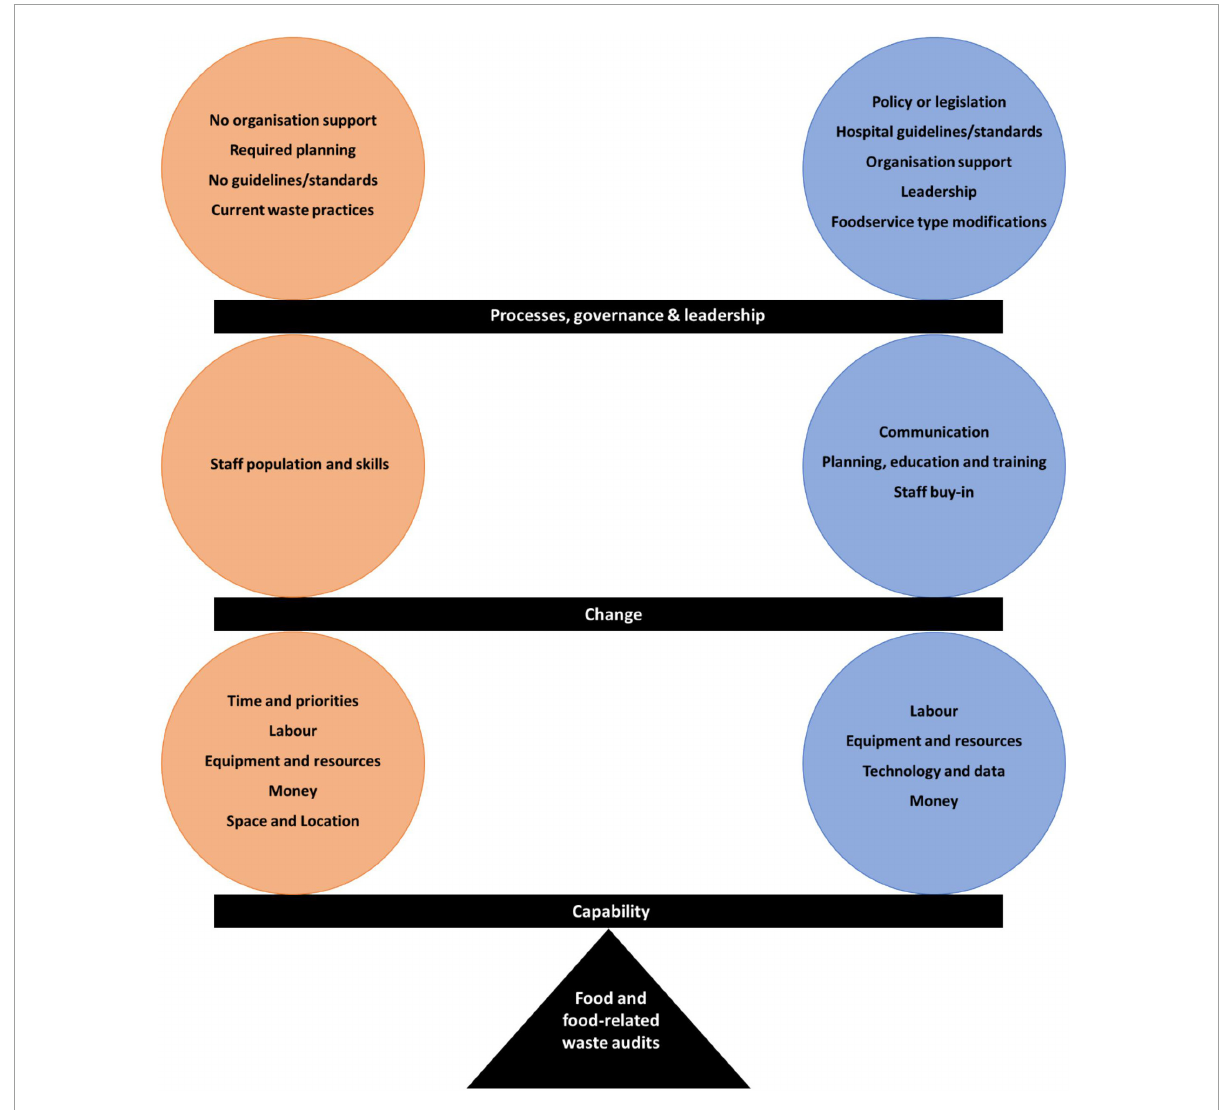
FIGURE2 Participant reported barriers and enablers to the completion of food and food-related waste audits. Orange circles represent barriers and blue circles represent enablers. White text are the major factors and the black text are individually generated